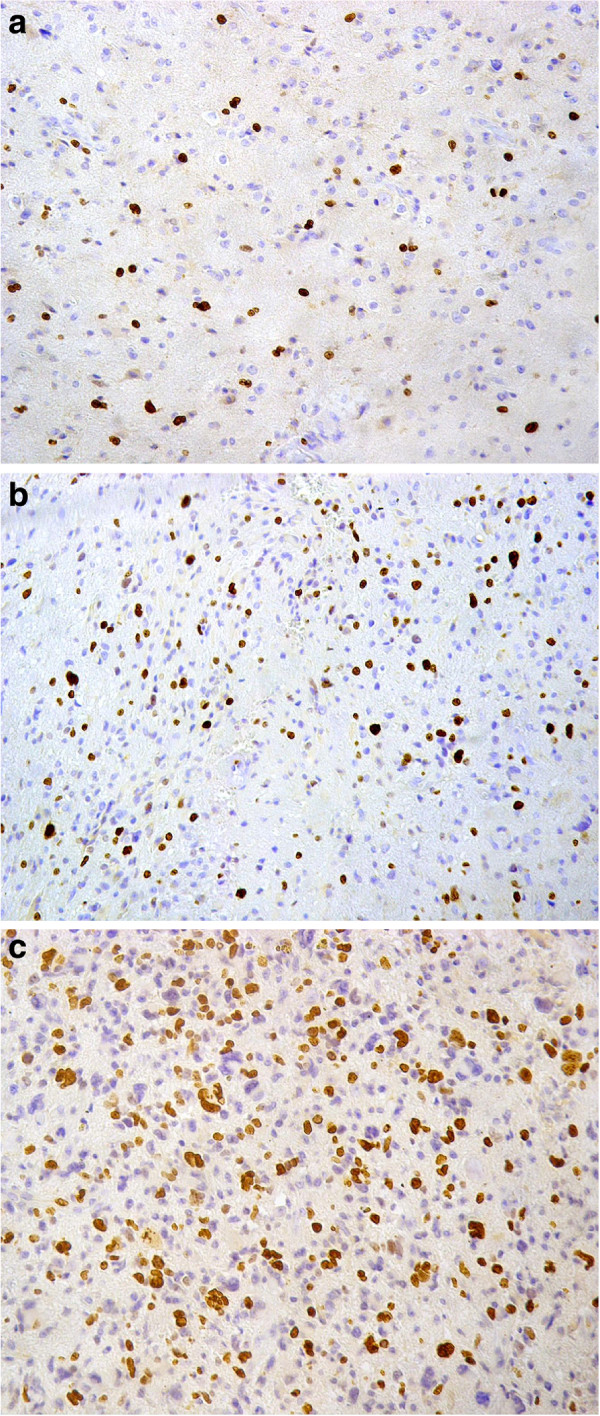
MIB-1 labeled nuclei in astrocytomas. a: In diffuse astrocytoma (MIB-1x200). b: In anaplastic astrocytoma (MIB-1x200). c: In glioblastoma (MIB-1x200).